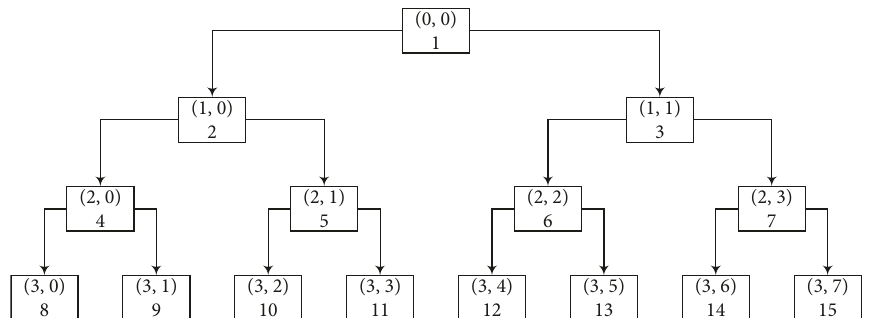
Figure 15: Wavelet packet structure